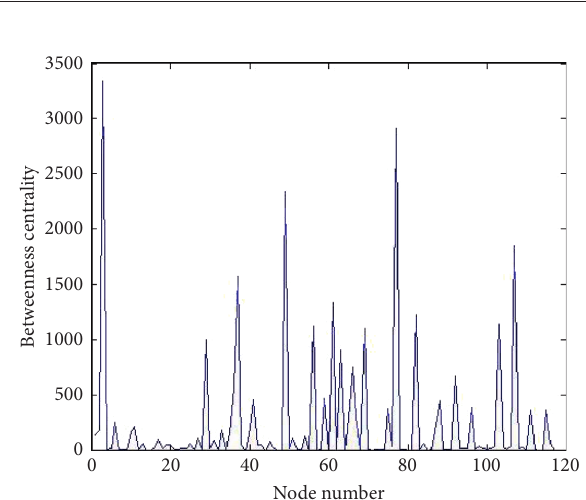
Figure 5: Betweenness centrality.